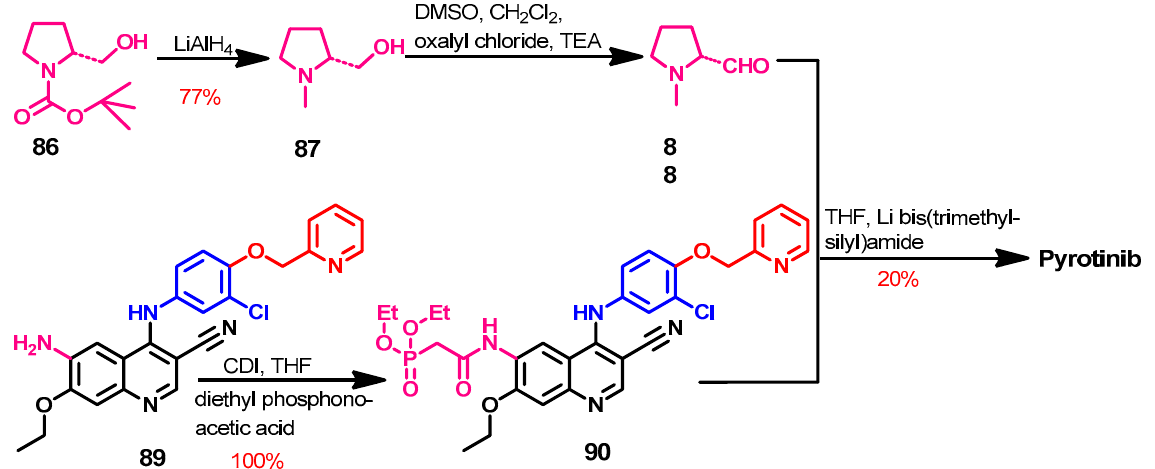
Scheme 12. Synthesis of pyrotinib; yield% was rounded up to the nearest